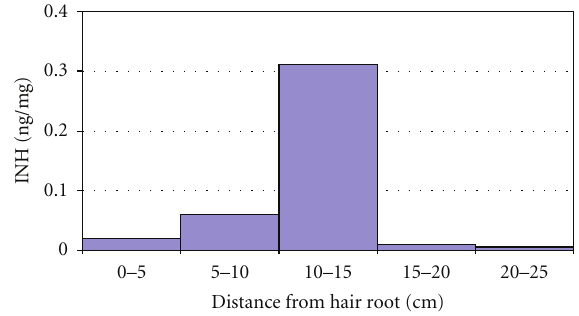
Figure 1: Isoniazid (INH) concentration in the hair shaft as func- tion of distance from the scalp (cm) obtained 9 months after ces- sation of a 3-month course of